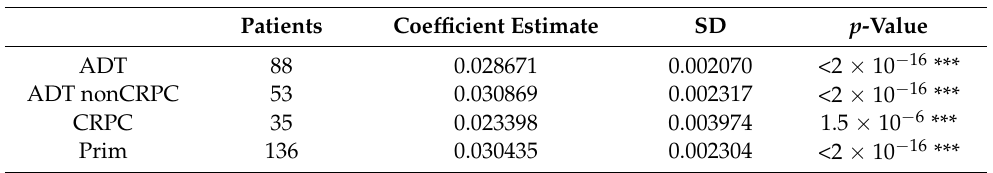
AR splice variants vs.